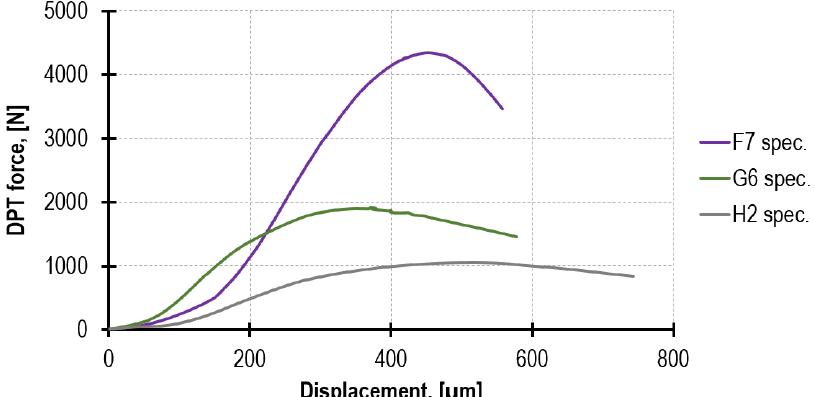
Figure 9. The comparison of the typical behavior of the three analyzed mortars, F, G and H, on the example of random specimens—the test performed after 12 weeks. (The displacement was recorded only by the machine grips; therefore, it involves a small distortion resulting from the elastic strain of the steel punches and the possible presence of backlashes in the machine).